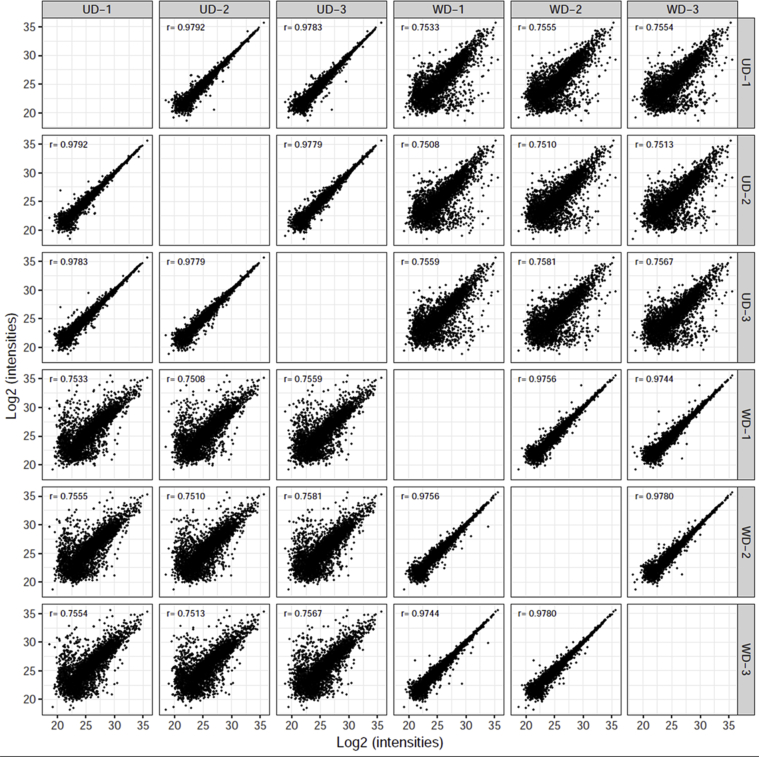
Correlation plot and Pearson correlation coefficients of well-differentiated normal human primary bronchial/tracheal epithelial cells and un-differentiated cells binary comparisons. UD and WD: un-differentiated and well-differentiated normal human primary bronchial/tracheal epithelial cells.